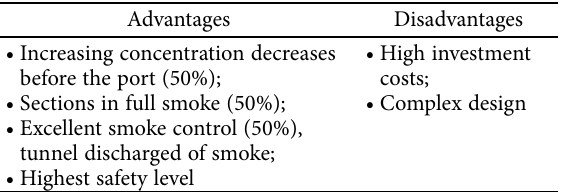
Table 3. Jet fans with shaft axial fans ( A 3 )